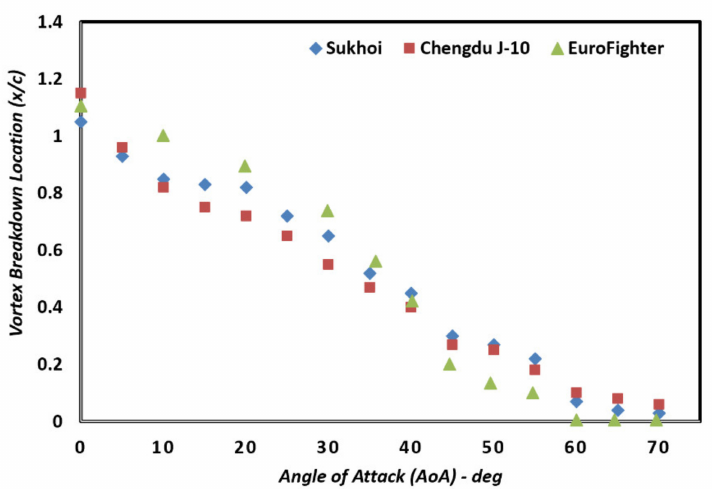
Figure 8. Vortex breakdown location (VBL) to the angle of attack of each